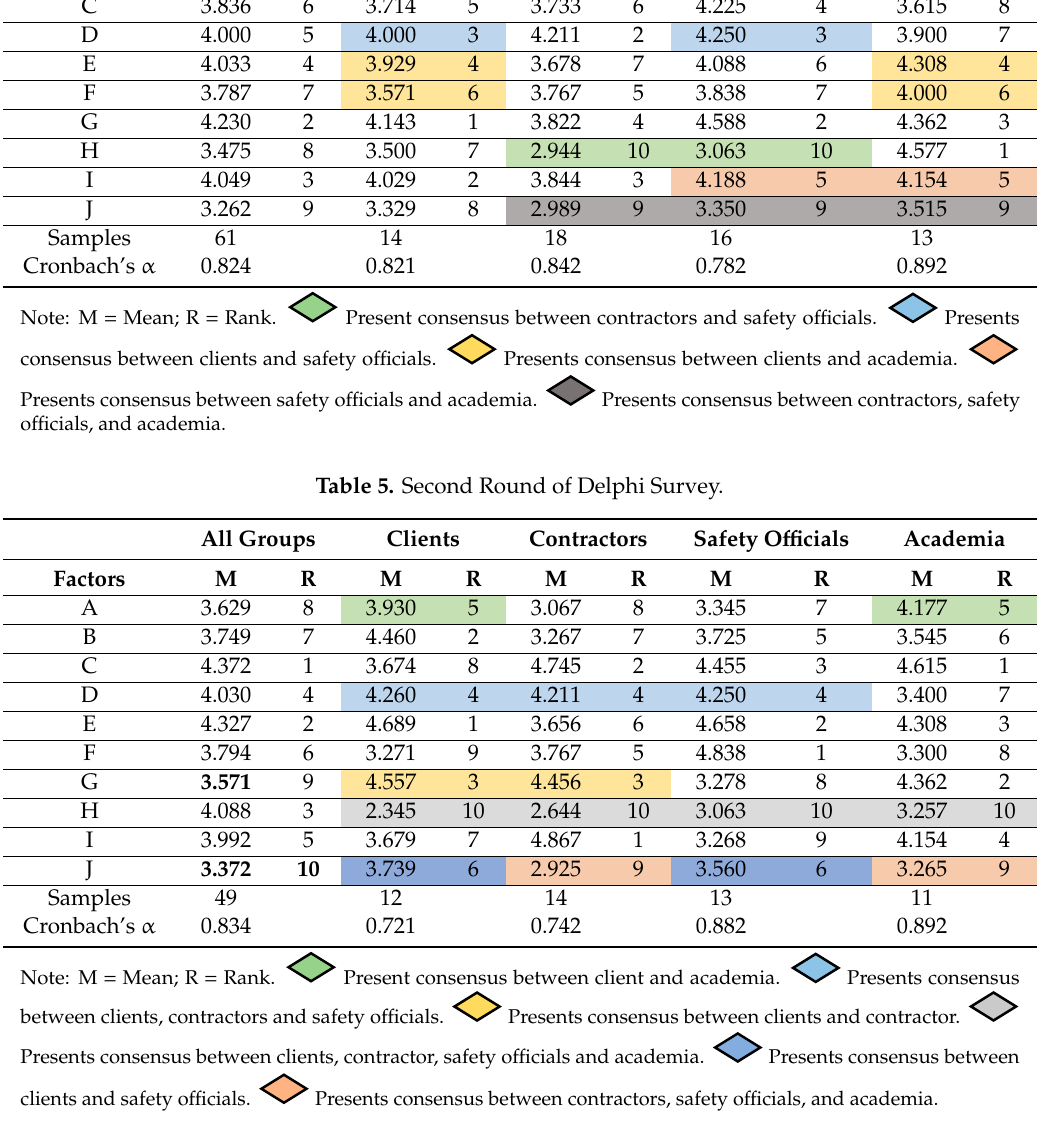
Table 4. First Round of Delphi Survey.